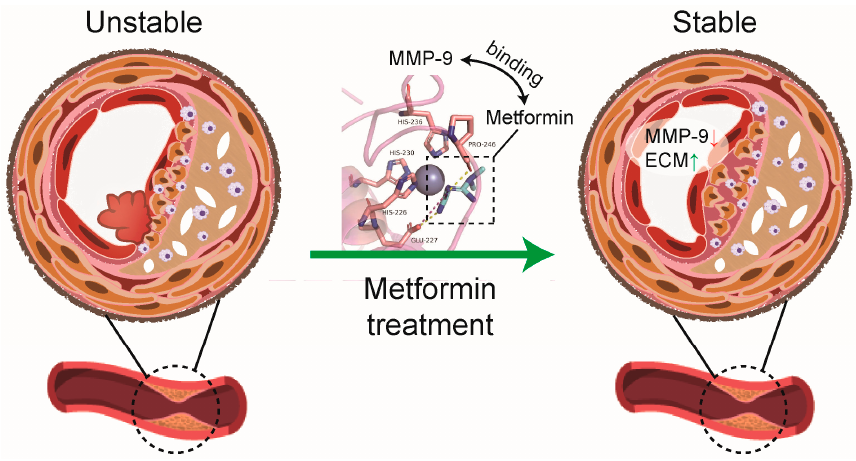
Figure 5. Schematic showing metformin directly binding to MMP-9 to improve plaque stability. MMP matrix metalloproteinase-9, ECM extracellular